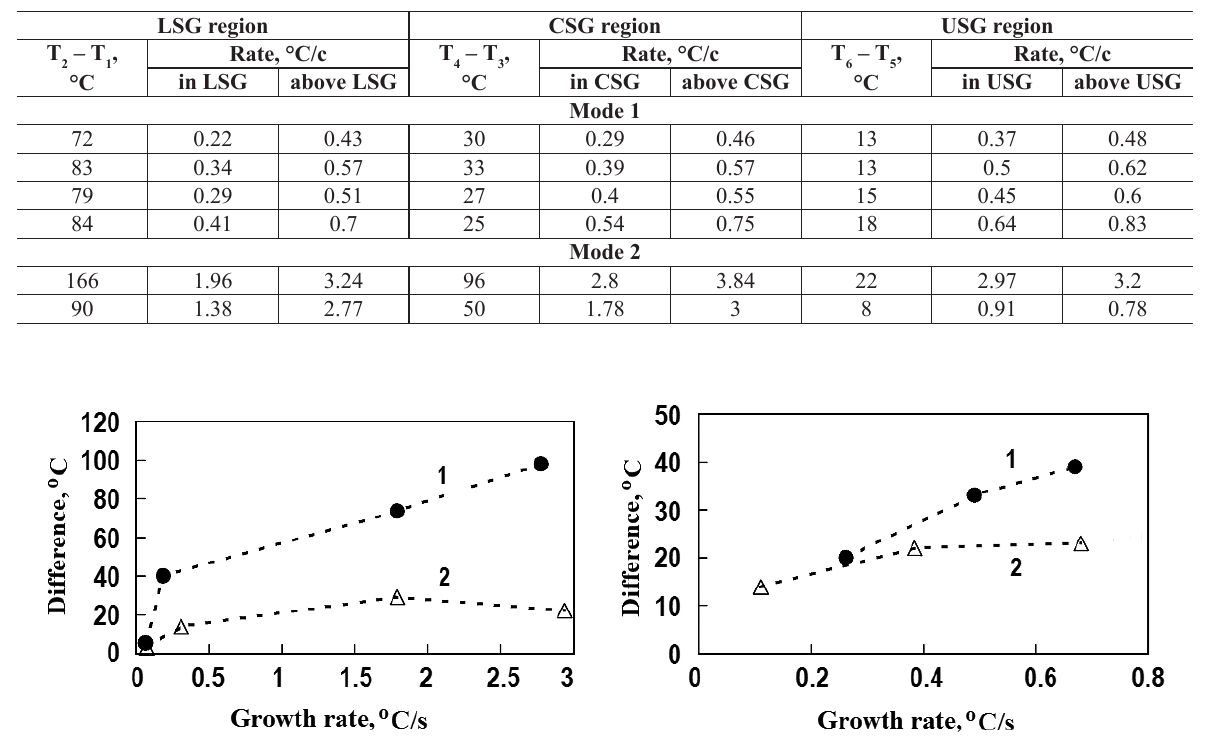
Figure 3. Variation of the difference in the TET readings for Т in the CSG (1) and in the LSG (2) at 300°C (а ) and 600°C